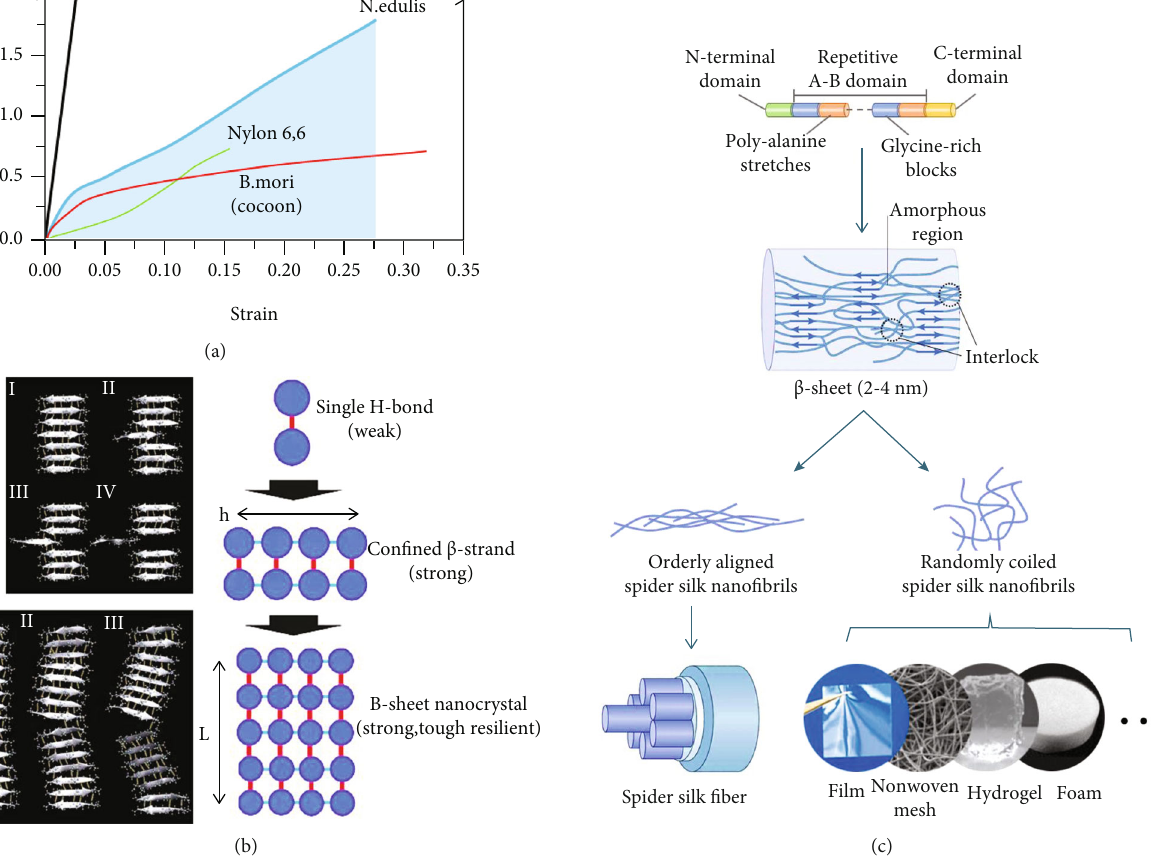
Figure 3: (a) The strain-stress curve of di ff erent fi ber materials including Kevlar 46, dragline fi ber of N. edulis , Nylon 6,6, and cocoon silk fi ber from B. mori ; the toughness of N. edulis dragline fi ber is illustrated by a colored area. Reproduced from C. Fu et al., 2009, Copyright © 2009, Royal Society of Chemistry. (b) Hierarchical organization of spider silk nanocrystals and deformation pro fi les of β -sheet crystals at di ff erent sizes. Reproduced from S. Keten et al., 2009, Copyright © 2021, Nature Publishing Group. (c) Hierarchical structure of